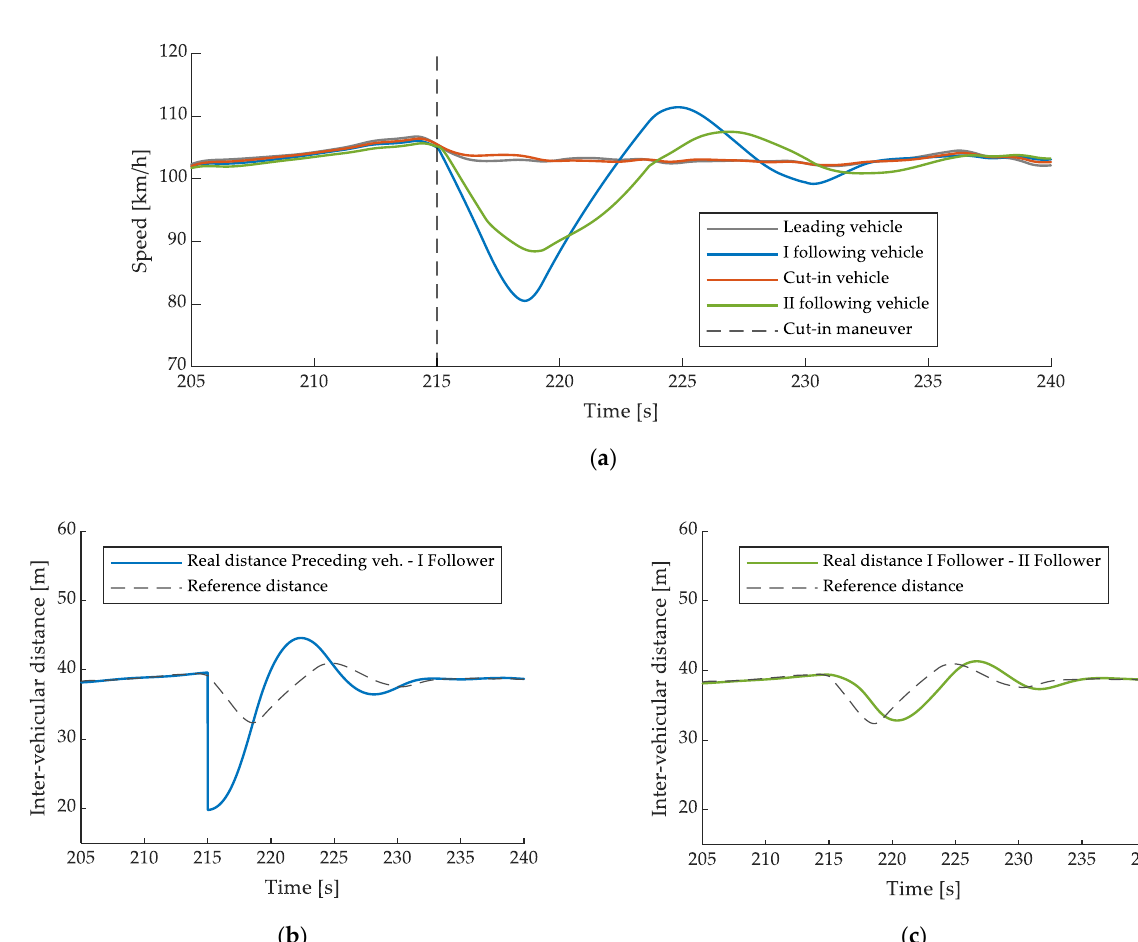
Figure A4. Safety analyses on a coasting phase of the US06 drive mission: ( a ) speed traces of the four vehicles (i.e., the three vehicles platooning and the fourth cutting in vehicle (in red)), ( b ) actual and reference inter-vehicular distances between the I follower and its preceding vehicle (i.e., the leader until the cut-in maneuver occurs and then the cut-in vehicle), and ( c ) actual and reference inter-vehicular distances between II and I followers.